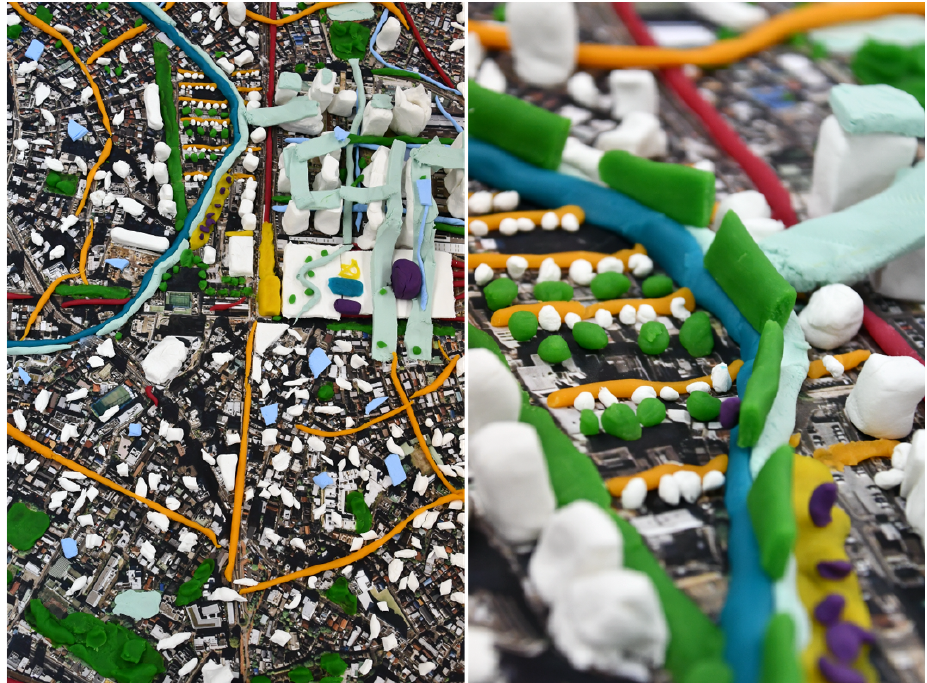
Figure 4. Plasticine modelling of the collective design propositions.